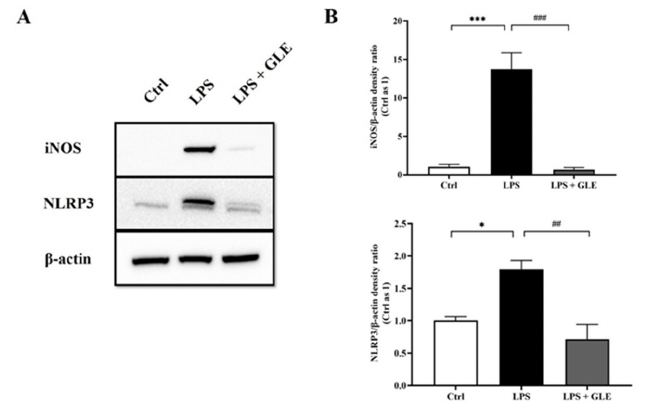
Figure 4. The effect of GLE on proliferation activity in LPS-induced BV-2 cells. Values are expressed as mean ± SEM of BV2 proliferation activity from three independent experiments. ***: p < 0.001, Ctrl group vs. LPS group; #: p < 0.05, LPS group vs. GLE treatment groups. All experiments were re- peated at least in triplicate.